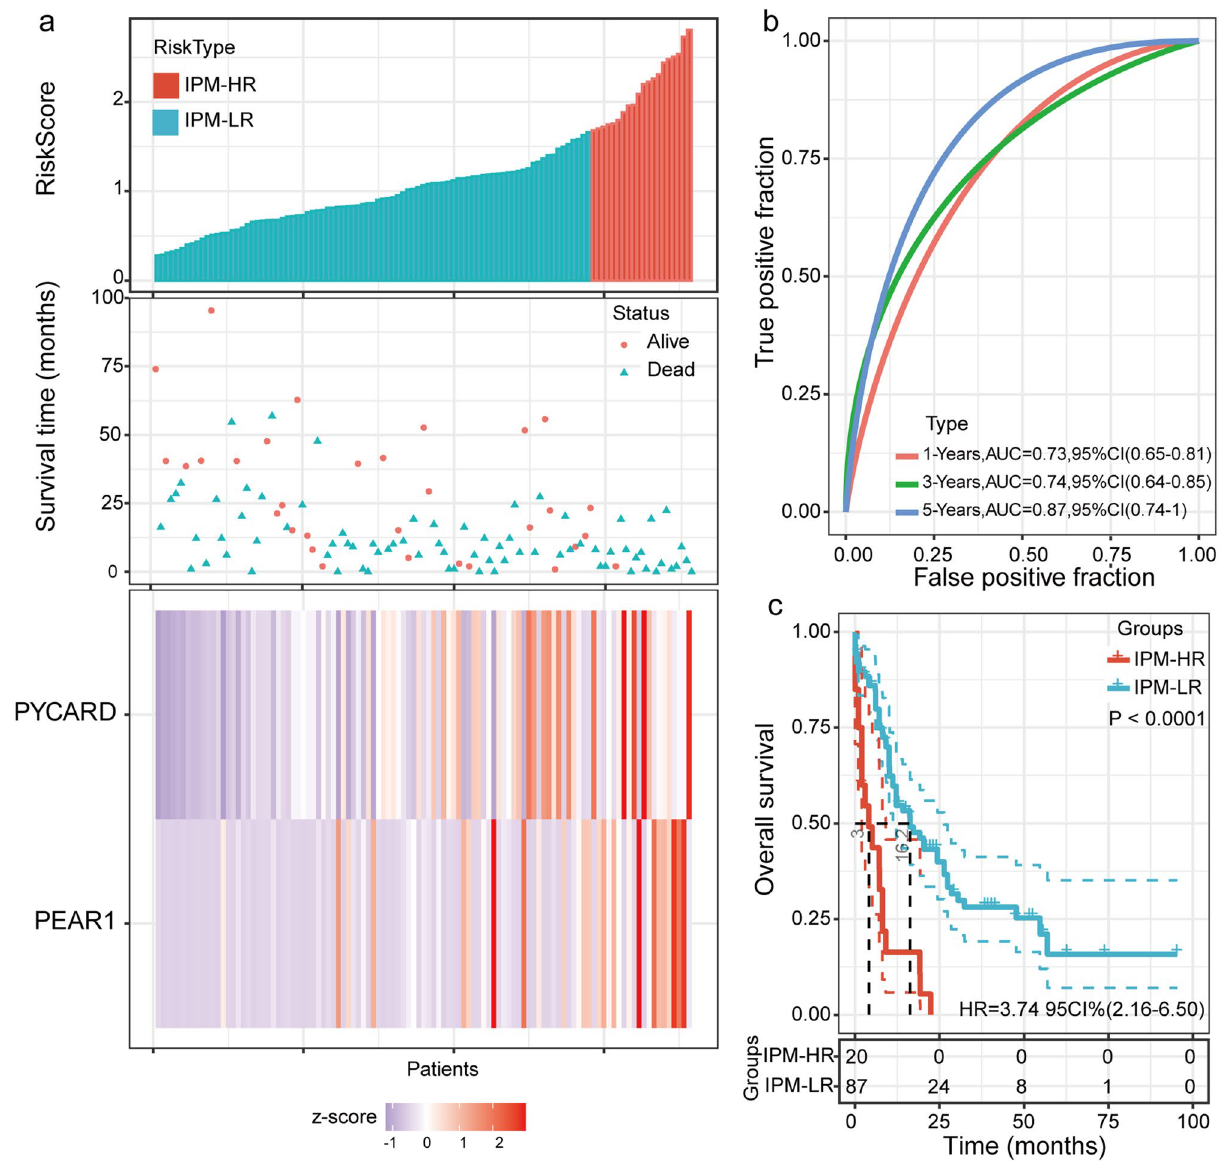
Figure 2. Establishment of an IPM and evaluation of its predictive ability in TCGA AML patients with intermediate and adverse-cytogenetic risk. ( a ) Risk score distribution and the corresponding survival and gene expression data; ( b ) Time-dependent ROC curve of the IPM; ( c ) Comparison between overall survival in the IPM-HR and IPM-LR